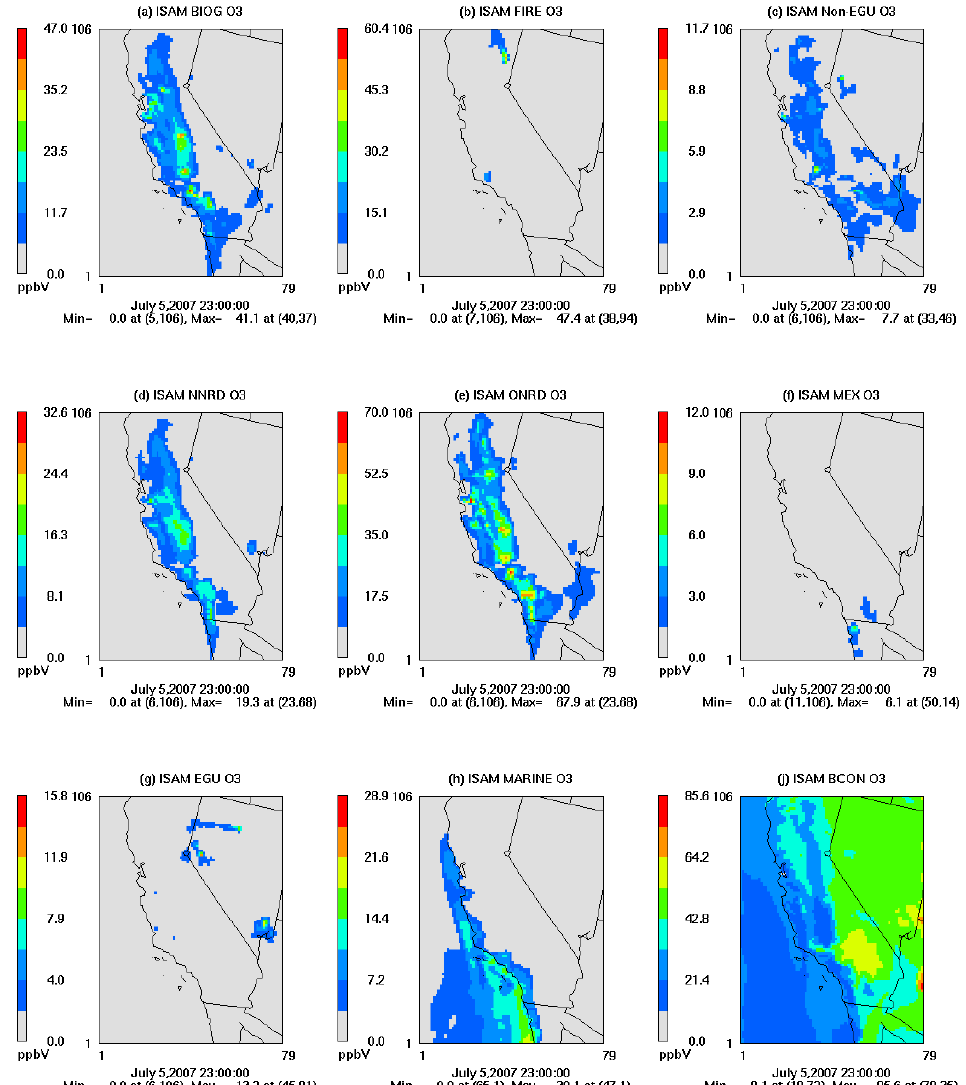
Figure 2. Spatial tiles of nine source sectors contributing to ambient O 3 , at 23:00UTC (16:00PDT) 5 July 2007. (a) biogenic BIOG, (b) wildfires FIRE, (c) non-electricity generation units Non-EGU, (d) non-road mobile NNRD, (e) on-road mobile ONRD, (f) Mexican point sources MEX, (g) electricity generation units EGU, (h) marine MARINE, and (j) boundary conditions BCON. Note different scales across the